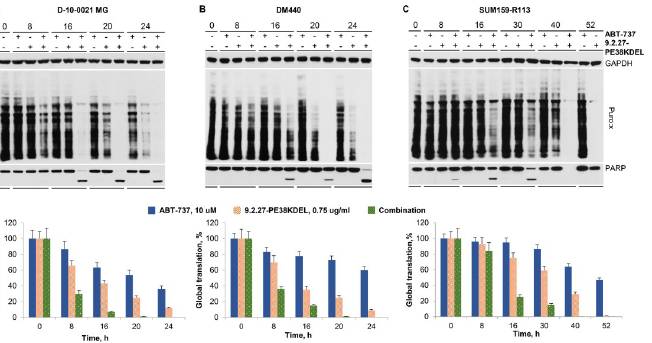
Fig 3. ABT-737 and 9.2.27-PE38KDEL induced changes in global translation and PARP in D-10-0021 MG, DM440, and SUM159-R113 cells. A-C. Inhibition of global translation and cleavage of PARP in D-10-0021 MG (A),